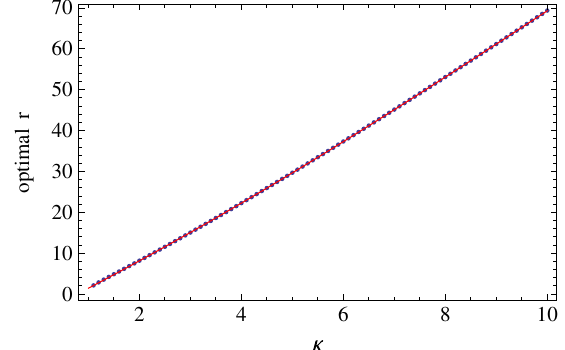
¼ opt ð (cid:12) Þ ¼ opt